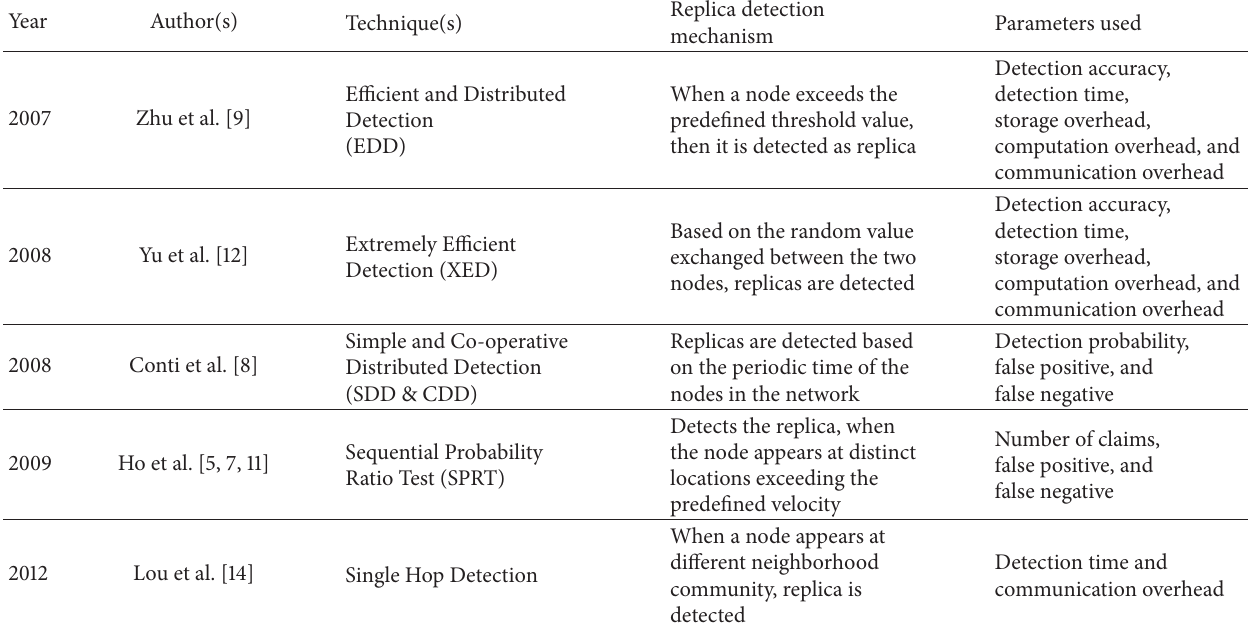
Table 1: Comparison of node replication attack detection techniques in Mobile Wireless Sensor